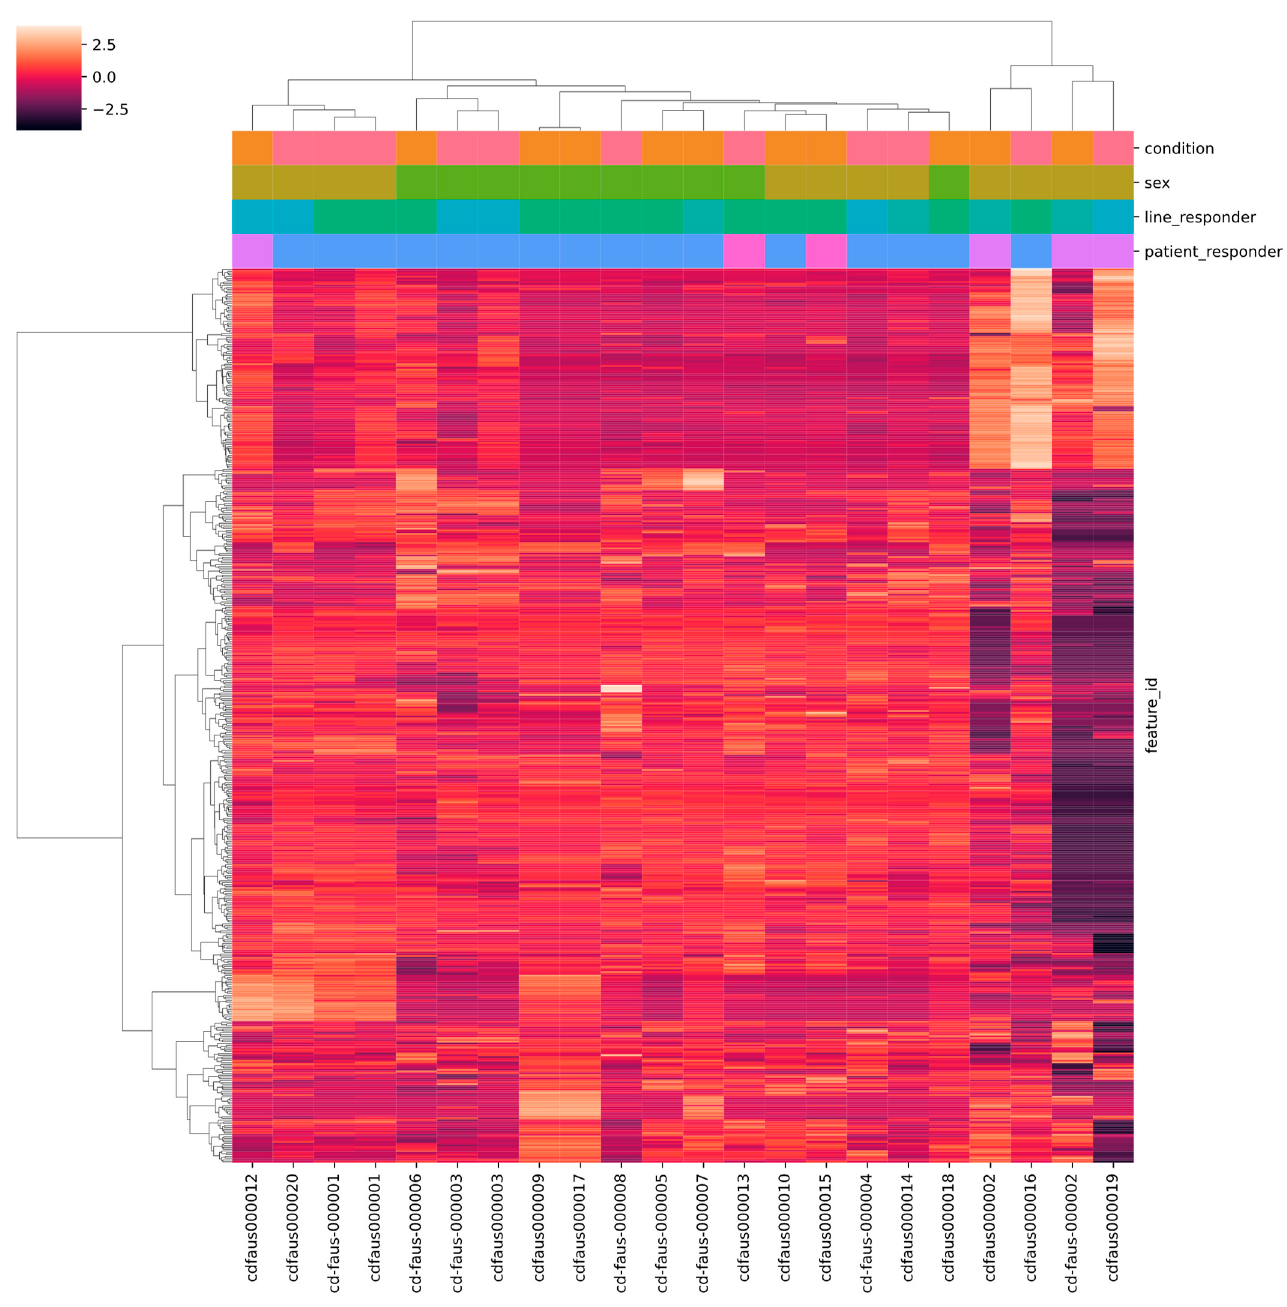
Figure 3. Hierarchical clustering and heatmap of the 500 most variable genes. The color bar at the top left side of the figure represents the relationship between colors and gene expression scaled values. The categorical phenotypes are annotated in the column side of the heatmap figure, and colored as follows: condition (orange MFS, pink UPS), sex (light brown F, green M), cell line responder (dark green UNKNOWN, light green R, blue NR), patient responder (blue UNKNOWN, lilac NR, fuchsia R). Both samples and genes were clustered using euclidean distance and ward linkage. Samples of the same sex show a tendency to cluster together, so this variable was treated as a confounder in subsequent analyses. The four samples clustering on the right side of the plot are those that were excluded from the analysis due to low NGS library quality and poor read yield. The two replicates of repeated samples (1, 2, and 3) showed consistent clustering, ensuring robustness of different library preparations across time.